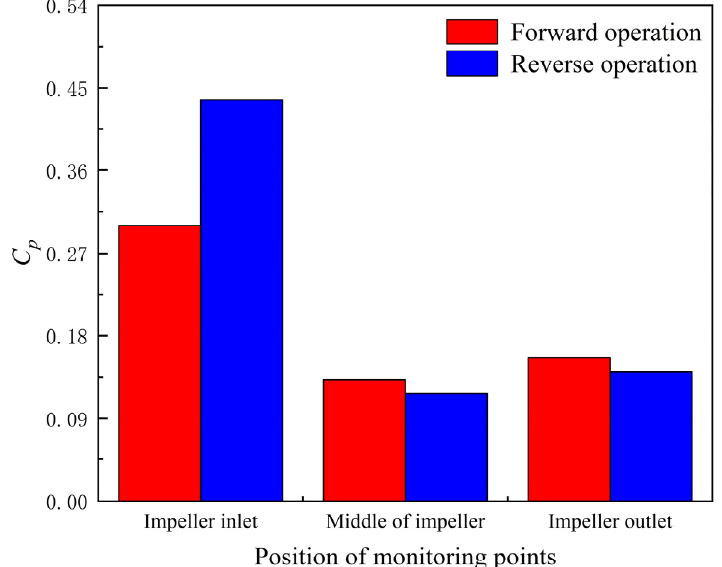
Figure 13. C p amplitude of main frequency of pressure pulsation of bidirectional axial flow pump under optimal condition of 1.00 Q bep .